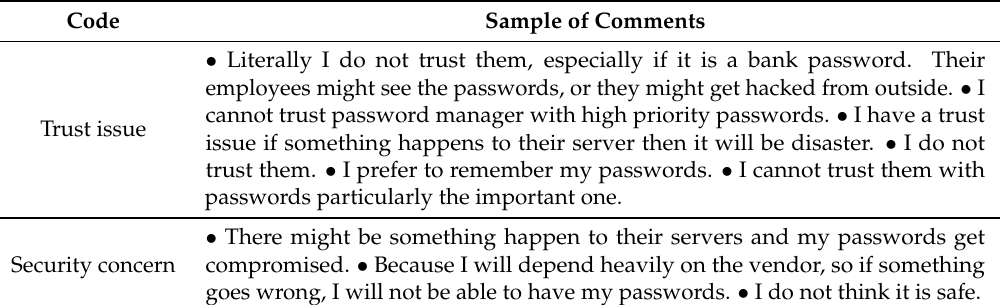
Table 13. Comments sample for the question “Trust the vendor of a password manager to